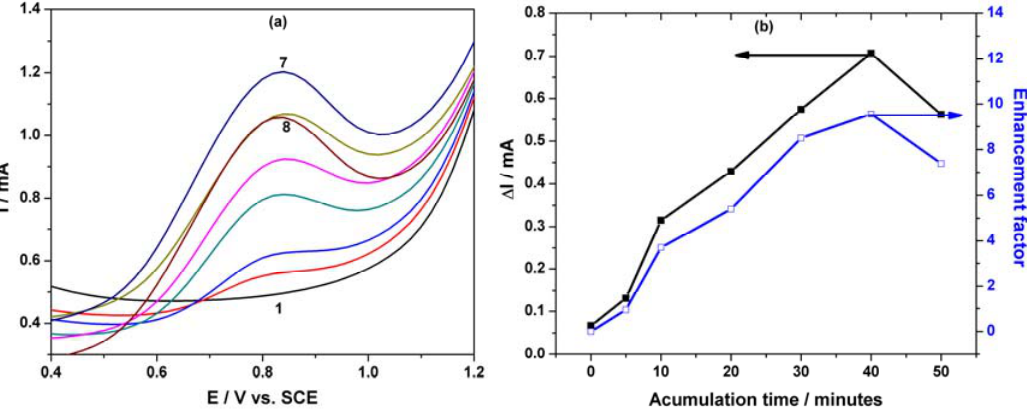
Figure 8. ( a ) DPVs of the MWCNT-EP composite electrode (modulation amplitude of 0.2 V, step potential of 0.02 V), and a potential scan rate of 0.05 Vs − 1 in the potential range between +0.5 V and +1.2 V vs . SCE in 0.1 M Na in the presence of 8 µM PCP concentration after different accumulation times: (2) 0